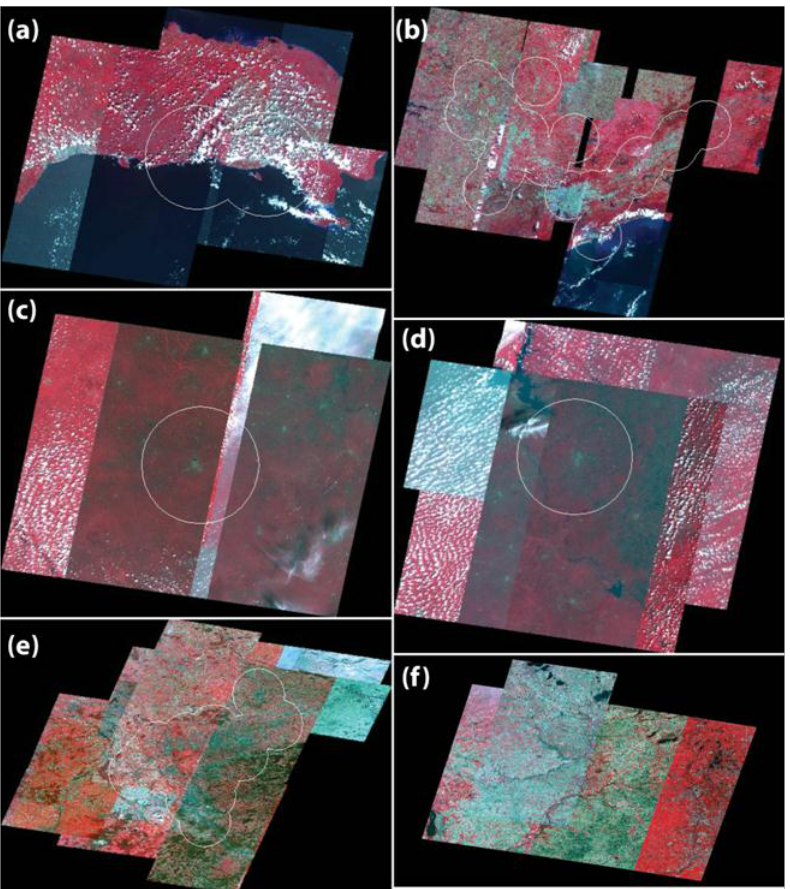
Figure 1. Examples of the results of manual selection of ASTER/VNIR images. The background images are false color composite of ASTER/VNIR. The white lines represent the boundary of the crowd of cities. (a) La Romana (Dominican Republic), (b) Sao Paulo (Brazil), (c) Gagnoa (Republic of Cote d'Ivoire), (d) Yamoussoukro (Republic of Cote d'Ivoire) , (e) Koln (Germany), (f) Rockford (United States of